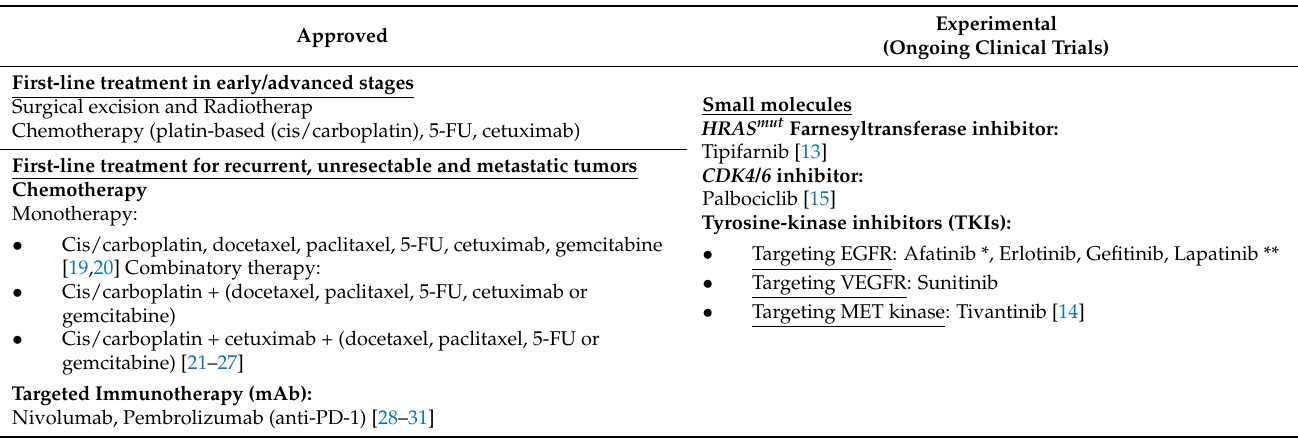
Table 2. FDA-approved and investigational drugs available for HNSCC